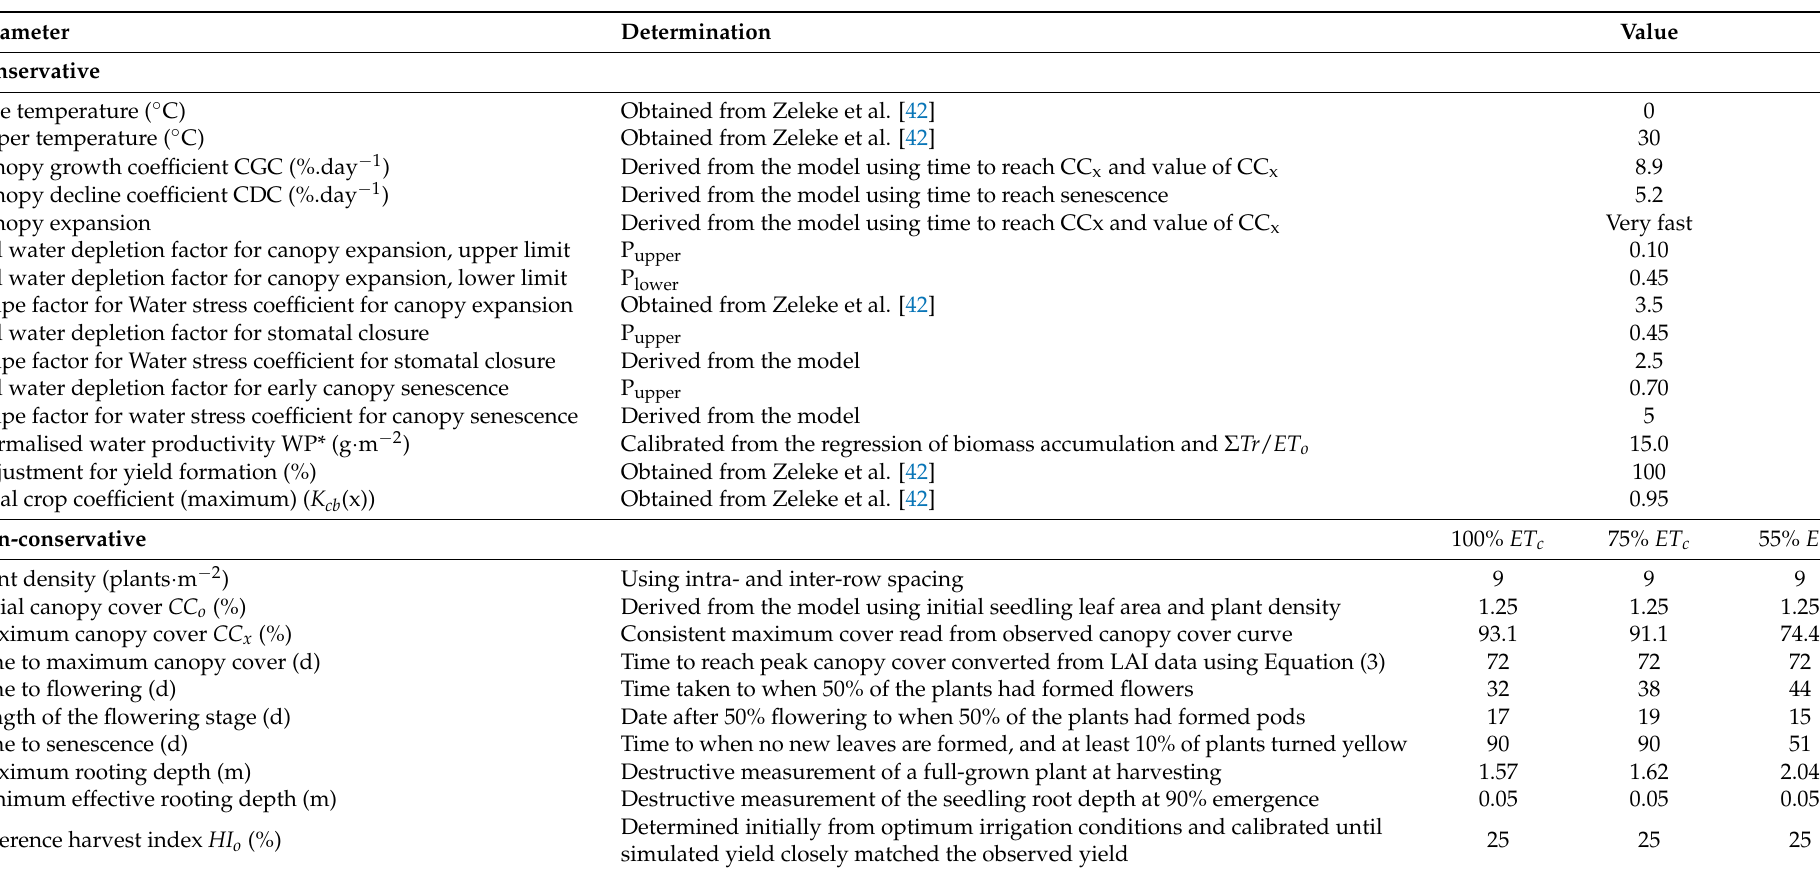
Table 4. Conservative and non-conservative parameters for